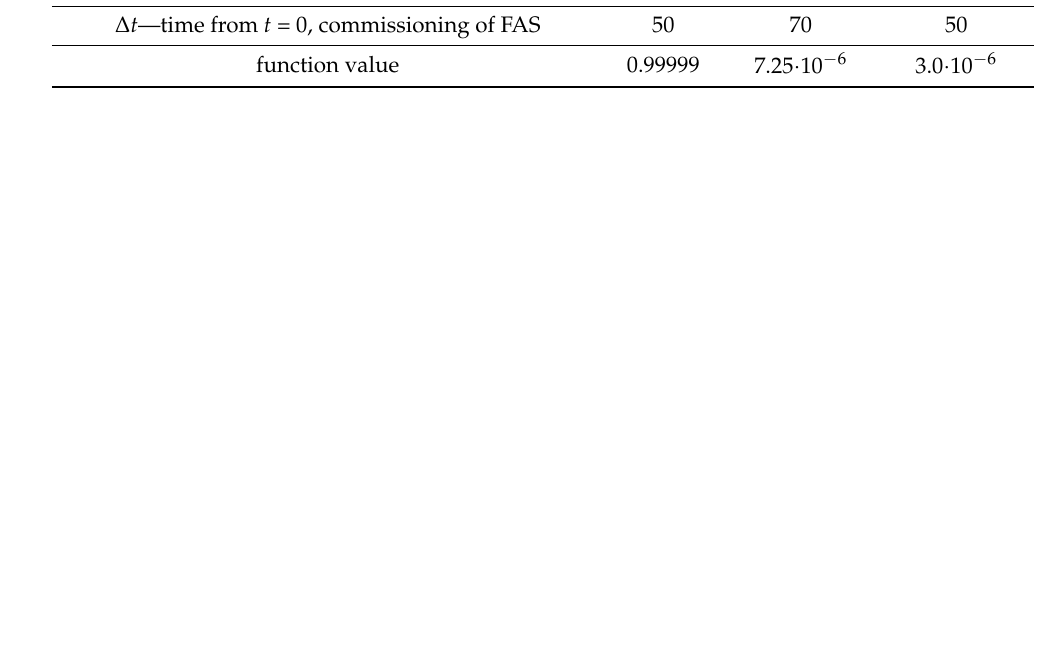
Table 2. Values of the FAS probability function at the initial time of use. The Function of the Probability of FAS Staying in R 0 ( t ) Q ZB ( t ) Q Z ( t ) Given Technical States ∆ t —time from t = 0, commissioning of